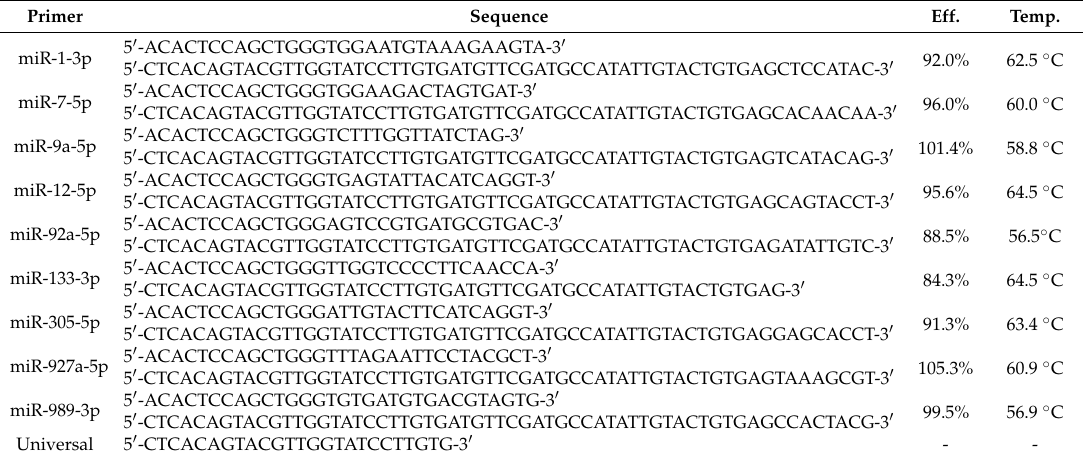
Top and bottom sequences represent forward and stem-loop primers, respectively. Abbreviations: Efficiency (Eff.); Temperature